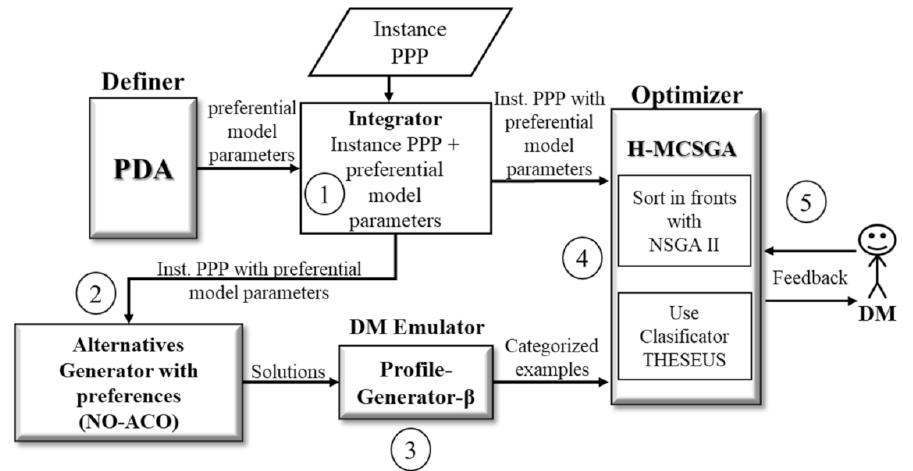
Figure 4. Phase 3: Incorporation of preferences in the solution